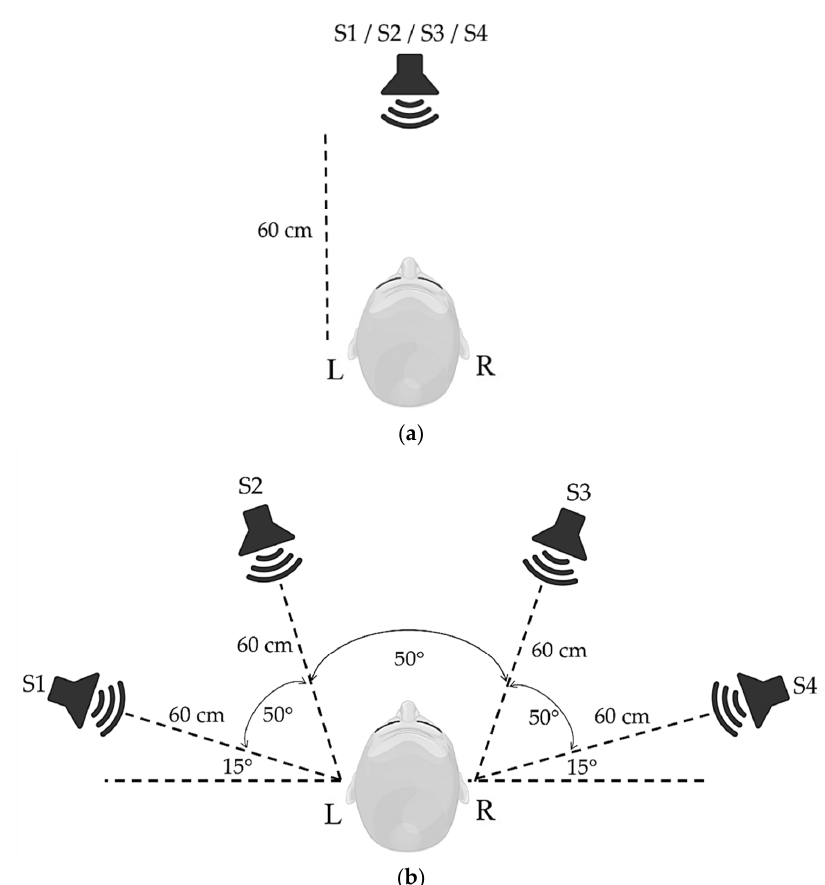
Figure 2. Two patterns of the loudspeaker position settings for auditory stimulation. ( a ) Single- loudspeaker position setting. ( b ) Four loudspeaker position settings in front of the participant.